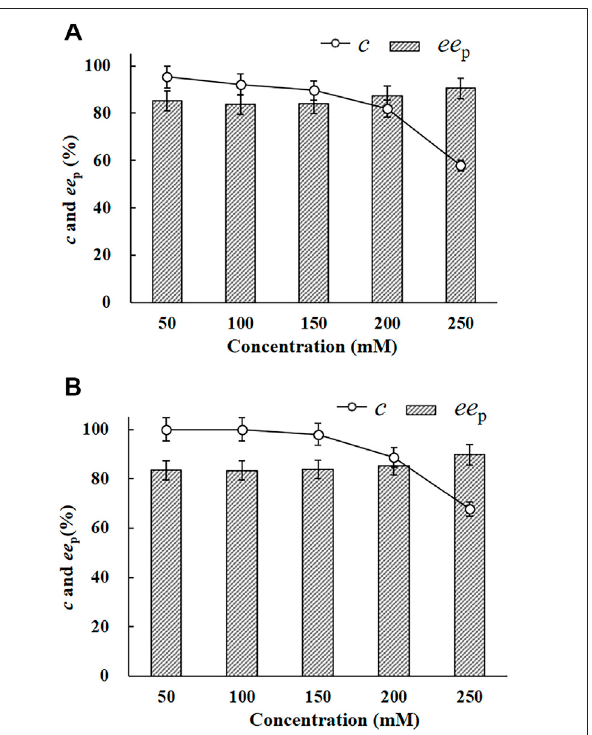
FIGURE2| Theenantioconvergent hydrolysisof rac-p CSO inthe4%(v/ v) Tween-20/phosphate buffer system (100 mM, pH 7.0) using 200 mg/ml wet cells of E. coli / pveh 1 z4x4-59 at 25 ° C for 12 h (A) and 24 h (B) . The hydrolytic reactions of rac-p CSO at 50 – 250